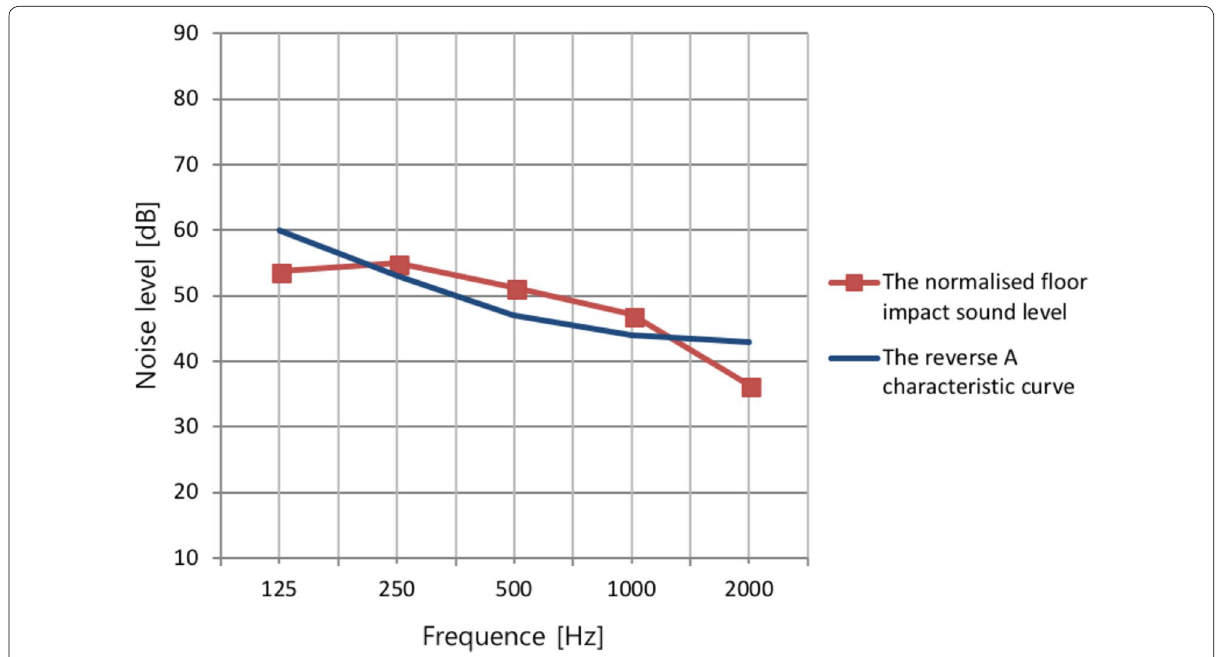
Fig. 5 Test result of the lightweight floor impact